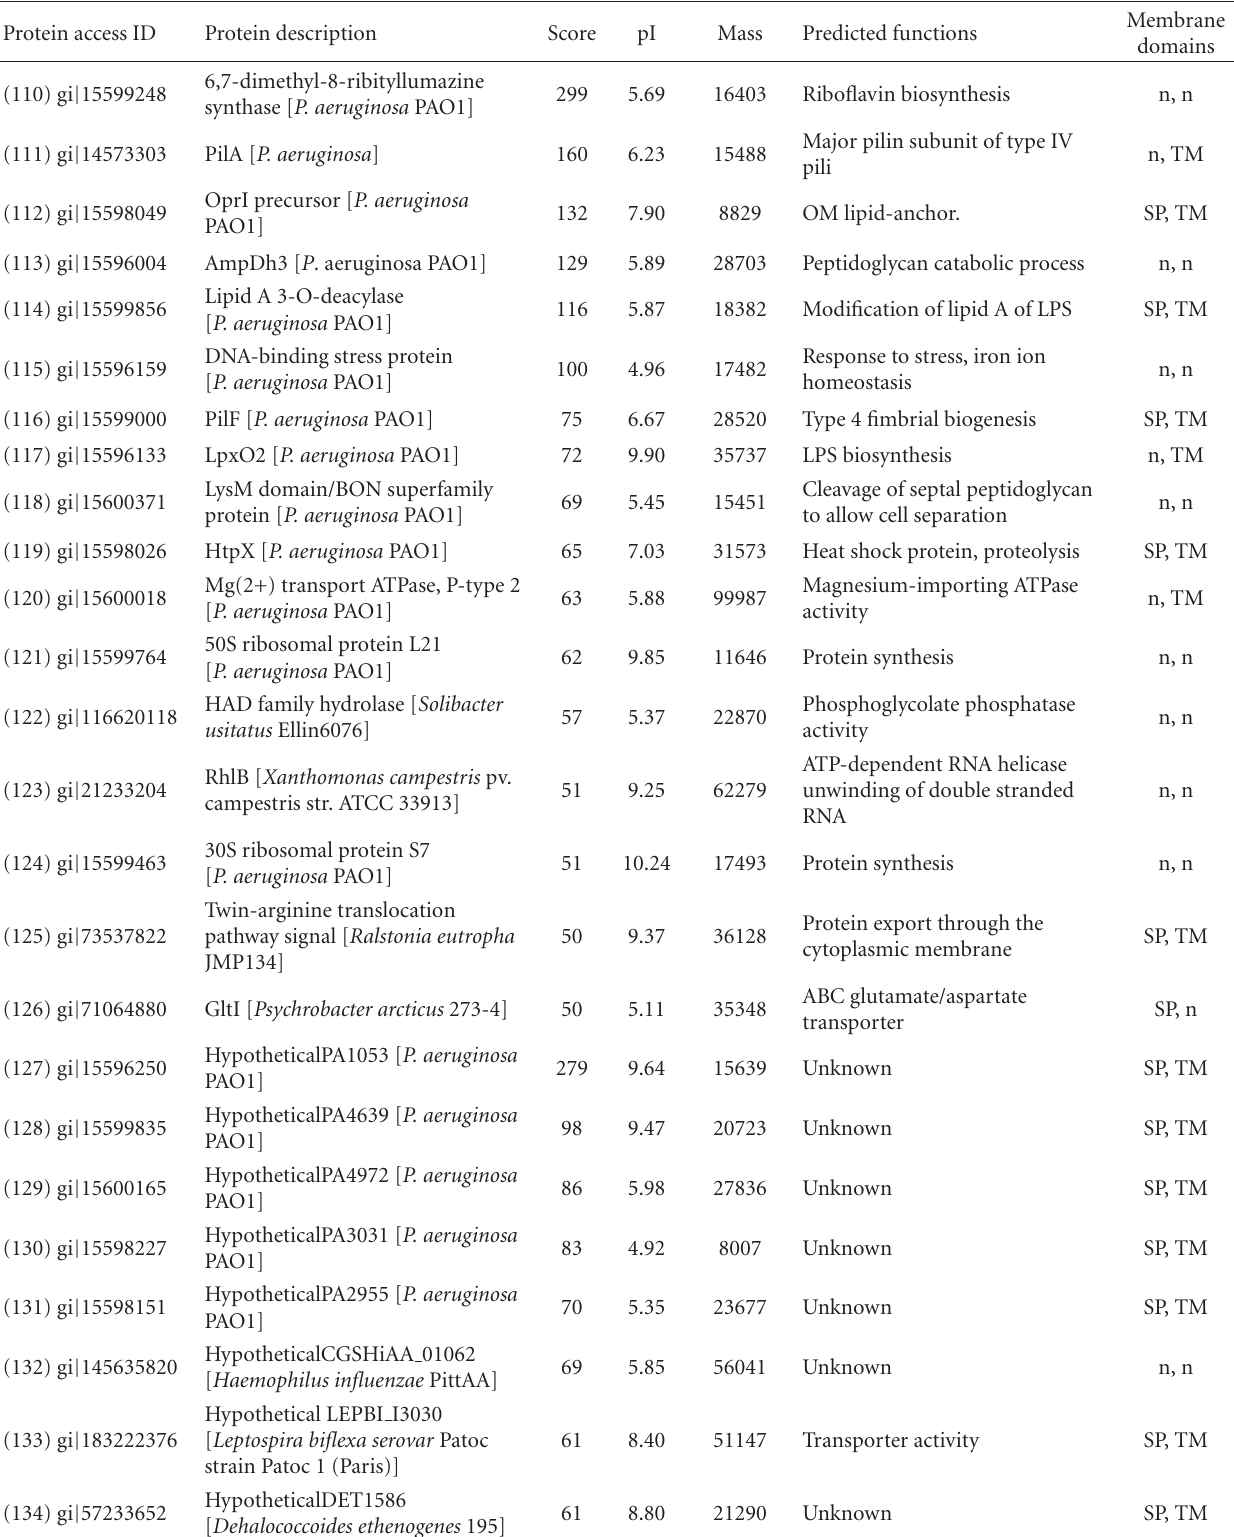
Table 3: The lexAN OMV